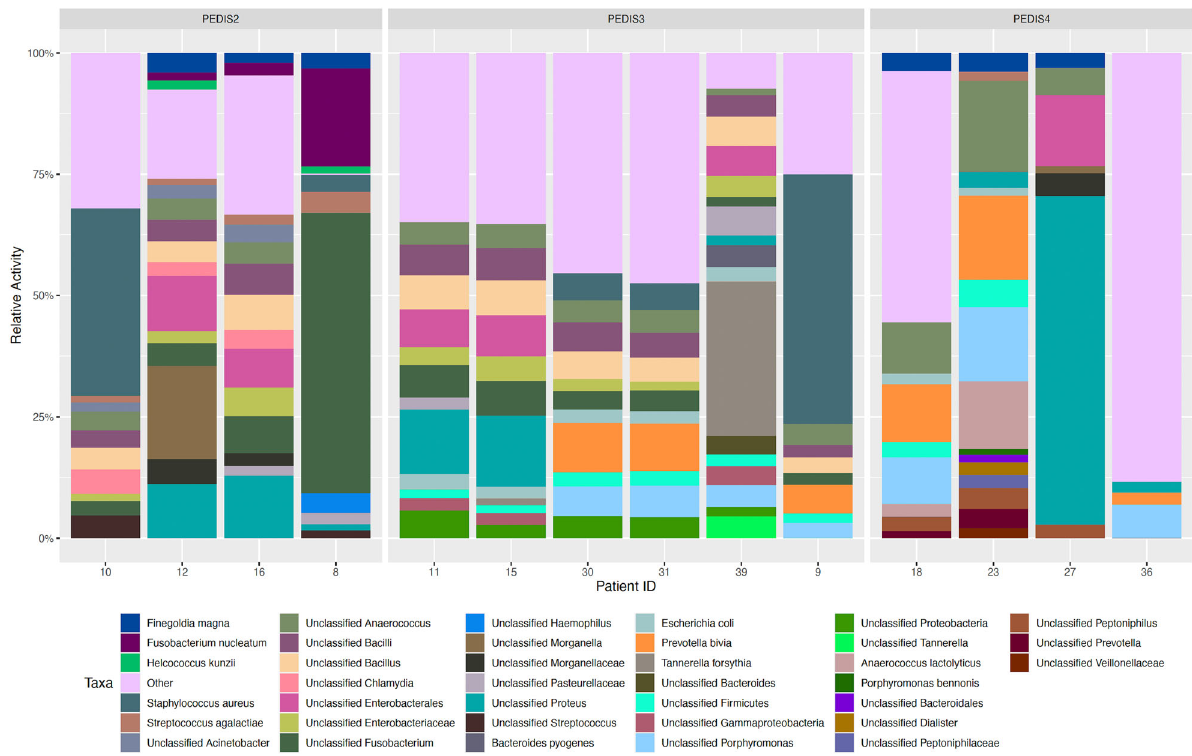
Fig. 2 Bar chart showing the top 20 most metabolically active taxa across each sample following metratranscriptomic analysis with the SqueezeMeta pipeline. Activity was based on normalized read counts (LogCpm) annotated to individual taxa and grouped according to infection severity (PEDIS group). Only taxa which comprises >1% of the total annotated microbiome are